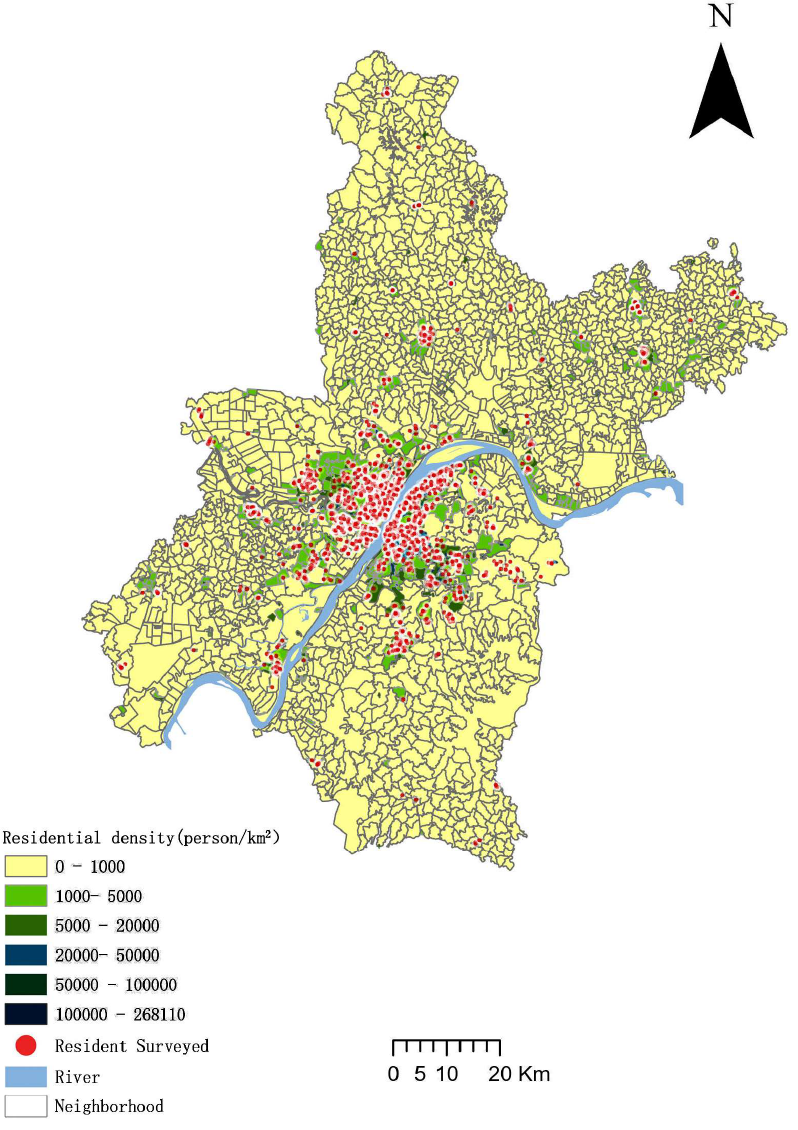
Figure 1. Spatial distribution of residents surveyed.